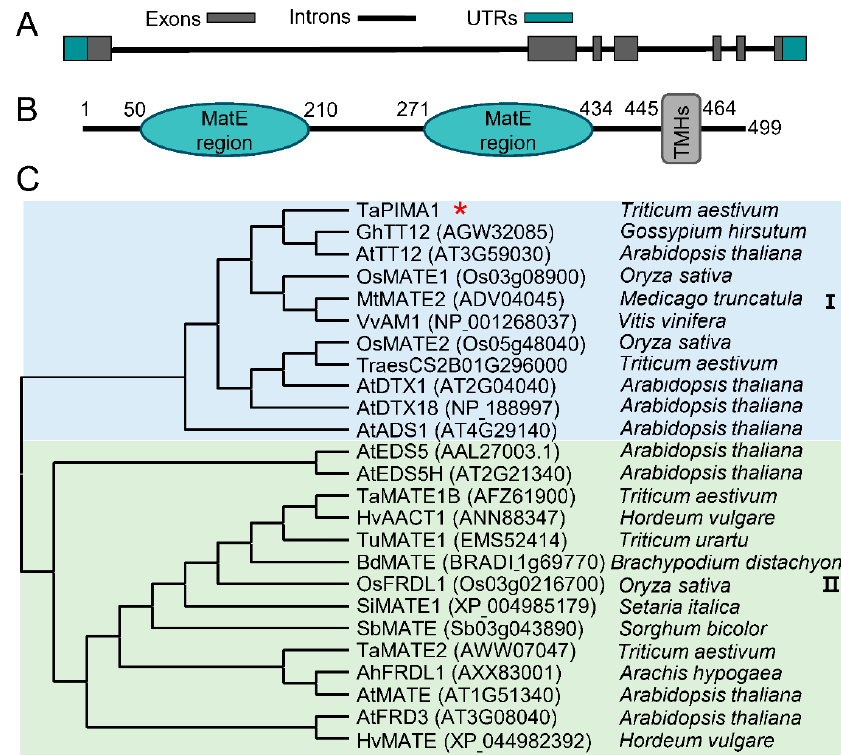
Figure 2. Sequence and phylogenetic analyses of TaPIMA1. ( A ) The genomic structure of TaPIMA1 in wheat CI12633 plant. The grey frames, green frames, and lines represent exons, UTRs, and introns regions, respectively. ( B ) Schematic of TaPIMA1 protein. There are two MatE domains (no. 50–210 aa and no. 271–434 aa, respectively) and a transmembrane region (12 TMHs, no. 445–464 aa) in TaPIMA1 protein. ( C ) Phylogenetic analysis of the TaPIMA1 and other MATE proteins by the maximum likelihood method. Asterisk indicates this TaPIMA1 protein. The phylogenetic tree was constructed using MEGA 11 software. The sequences were referred to EnsemblPlants, GenBank, and Phytozome database.